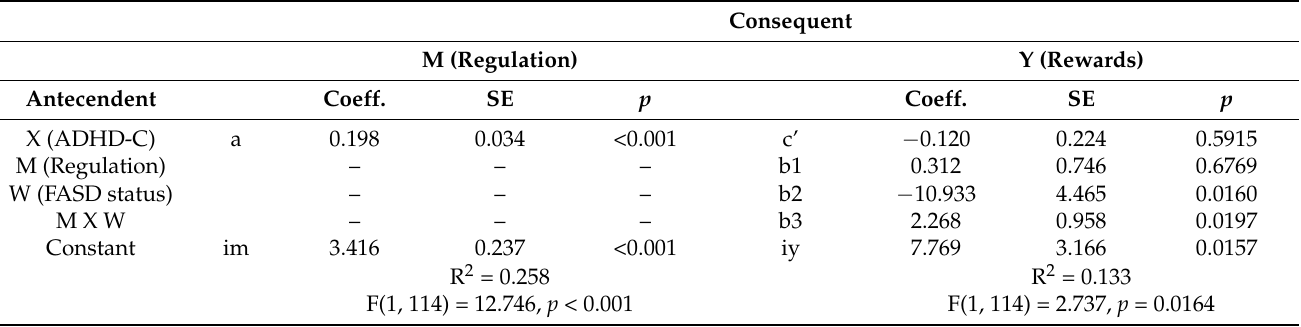
Table 3. The model coefficients and model summary information for the conditional process (Model 14) in the relationship between ADHD-Combined and the helpfulnes of rewards, where FASD diagnostic status moderated the mediation effect of Regulation.